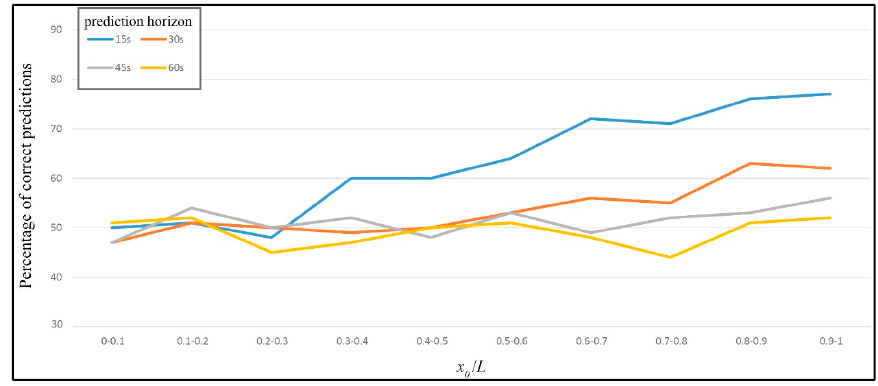
Figure 9. Changes in the percentage of the correct predictions with respect to the initial location of the vehicle.